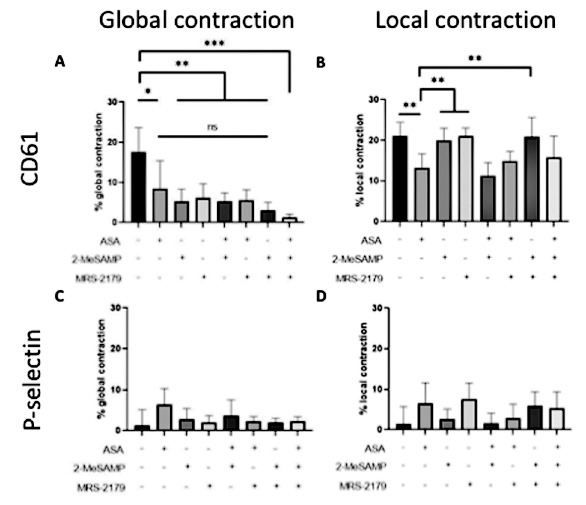
Fig.3 P-selectin þ platelets havelimitedglobal and local contraction; ASA, 2-methylthio (Me)-SAMP, and MRS-2179 have a limiting effect on global platelet contraction, while only ASA limits local platelet contraction. Images from ► Fig. 1 were measured for global and local contraction. Global contraction measured the change in distance in clot length between 7.5 and 15minutes images of a clot. Local contraction measured the change in percent area coverage of a clot between 7.5 and 15minutes. Global contraction for platelets (A) , local contraction for platelets (B) , global contraction for P-selectin (C) , and local contraction for P-selectin (D) were comparedamong the various conditions. (N ¼ 3 donors, n ¼ 6 clots for each panel; (cid:5) p < 0.05, (cid:5)(cid:5) p < 0.01, (cid:5)(cid:5)(cid:5) p < 0.001). ASA, acetylsalicylic acid.